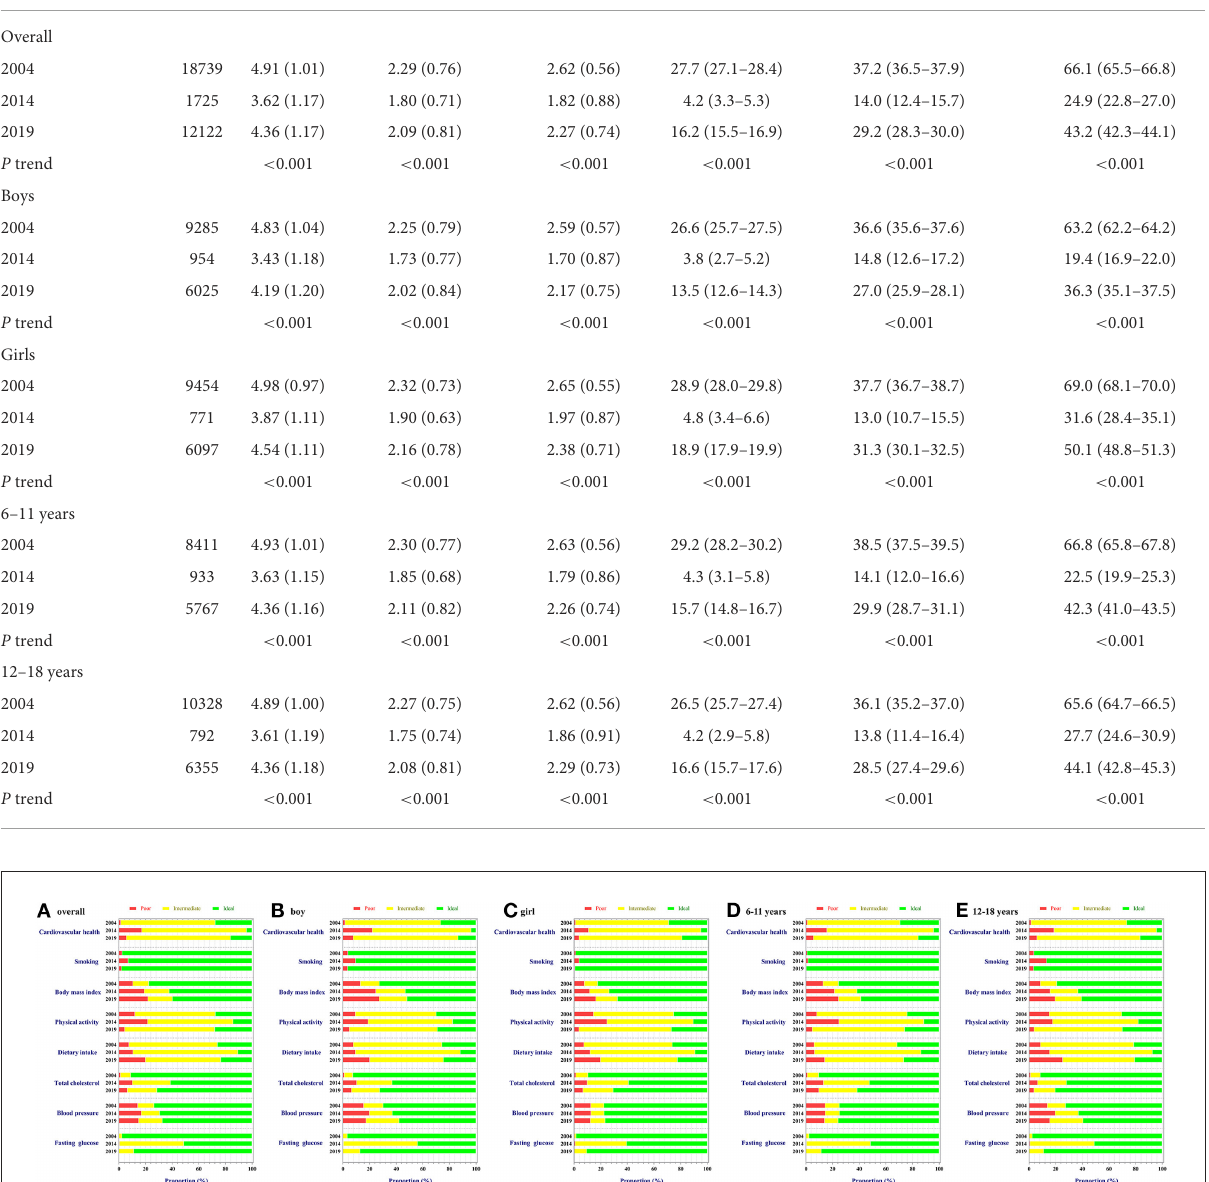
of ideal CVH. Individuals with overweight/obese fathers, overweight mothers, parental history of CVD, passive smoking, and high fat mass percentage were significantly associated with decreased odds of ideal CVH compared to the reference group.